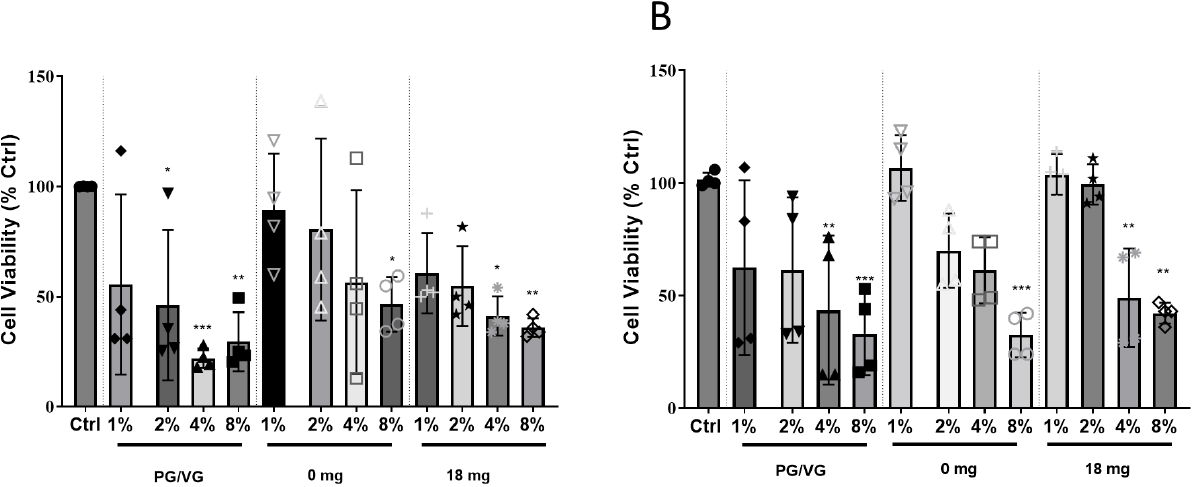
Figure 1. Cell viability in HCAEC exposed to ( A ) Direct effects of EAC. MTT Assay was performed on HCAEC after exposure to various concentration of EAC generated from: (i) a PG/VG solution (non-flavoured), (ii) 0 mg nicotine (tobacco flavoured), and (iii) 18 mg nicotine (tobacco flavoured) for 24 h. ( B ) Indirect effects of EAC. A549 epithelial lung cells were exposed to EAC under the same conditions. Media from the treated A549 cells were then used to treat HCAEC on a separate plate for 24 h before cell viability was assessed via MTT assay. Results are expressed as mean ± SEM (n = 4 biological replicates). One-way ANOVA with Bonferroni post-tests was used for statistical analysis; * p < 0.05, ** p < 0.01, *** p < 0.001 versus Ctrl.